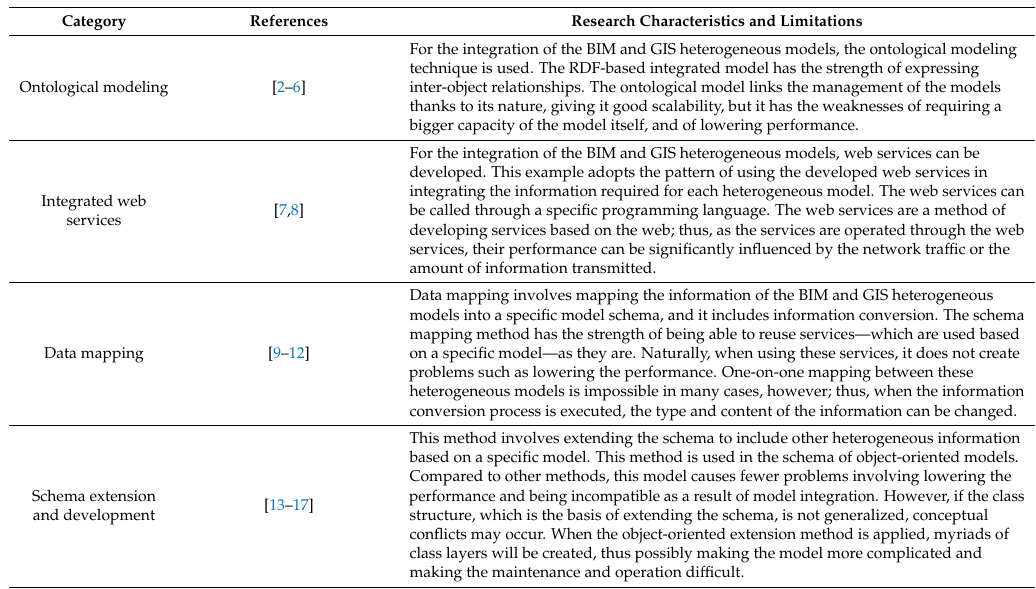
Table 1. Analysis of